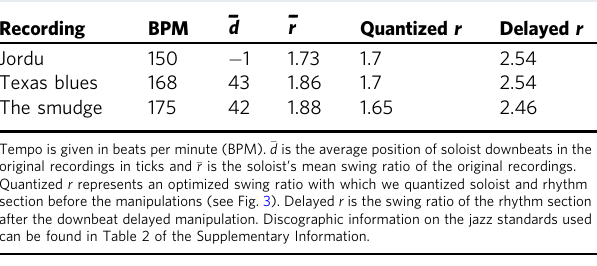
Table 2 Characteristic parameters of the recordings used